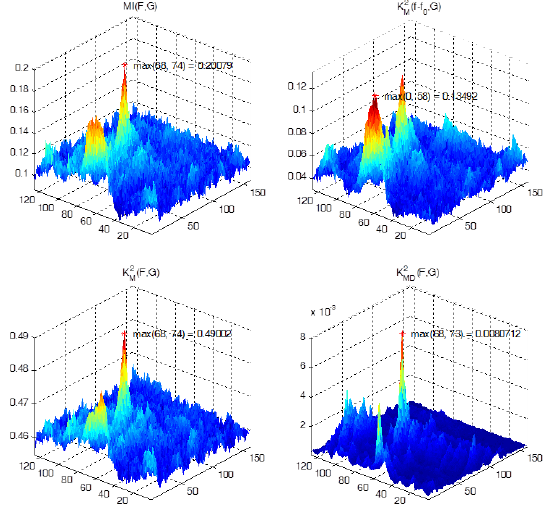
Figure 6. Correlation fields for TV-IR matching (Example